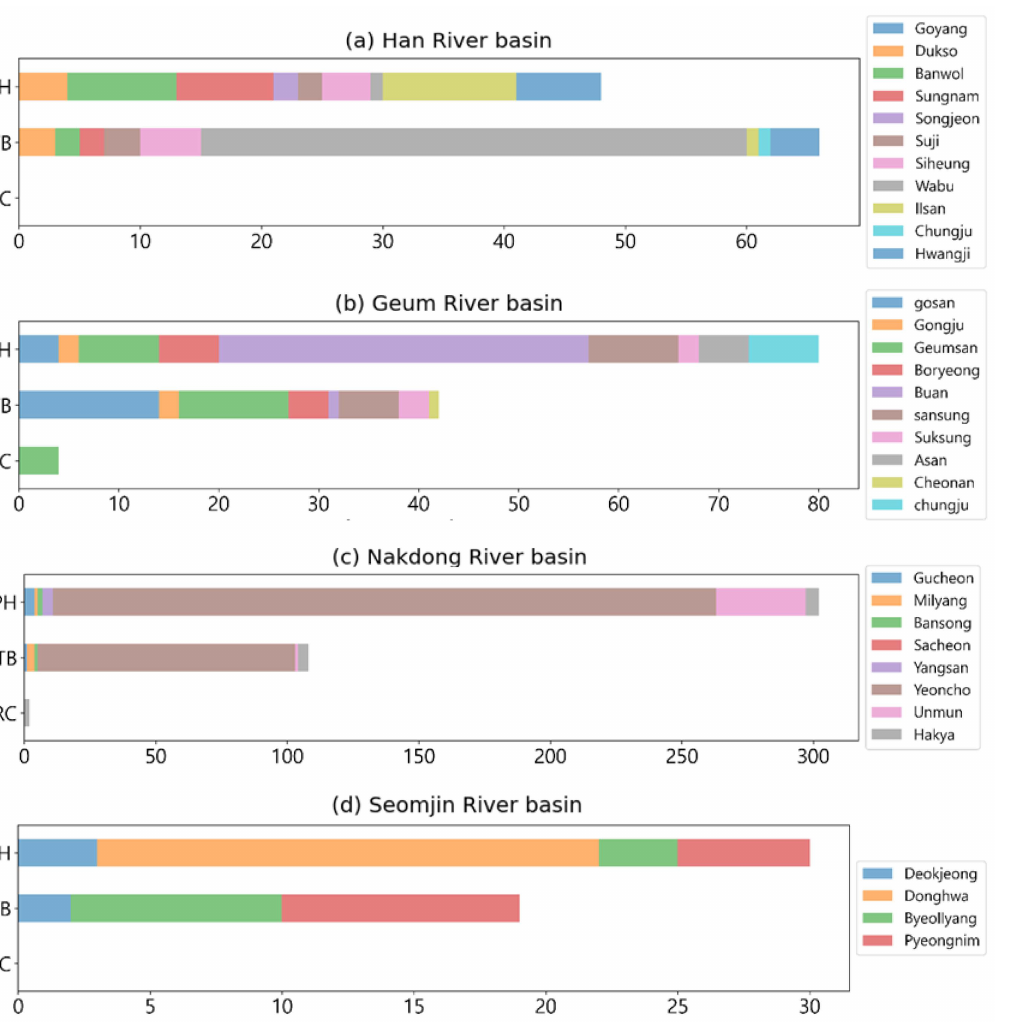
Figure 8. Frequency of water quality anomalies in the Han, Geum, Nakdong, and Seomjin River